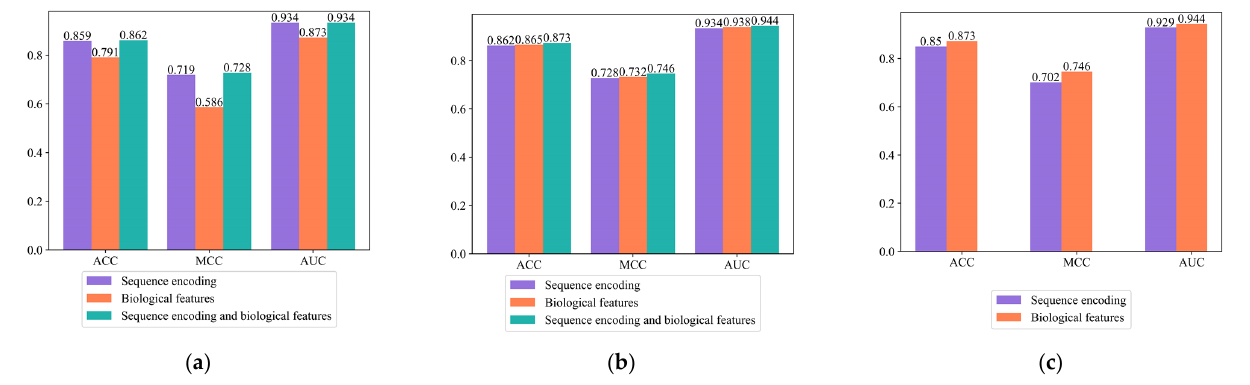
Figure 3. Comparative experiments performance. ( a ) The effect of different encoding modes on model performance. ( b ) The effect of using different features on model performance. ( c ) The effect of self-attention on model performance.